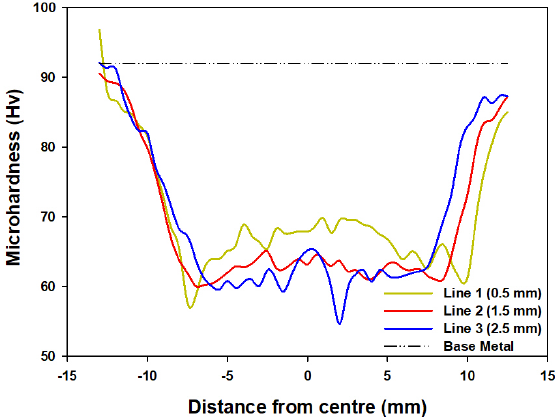
Figure 13. Vickers microhardness profile of the FSP AA6082 sample.